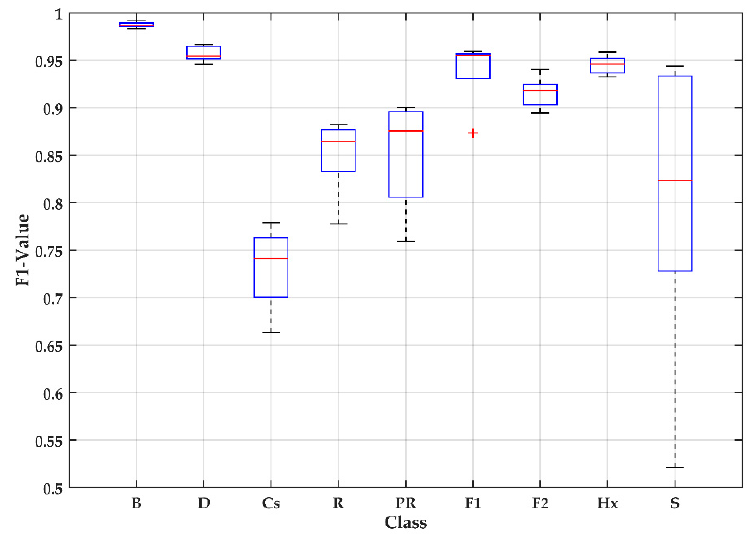
Figure 9. F1-values for each category. Figure 9. F1 ‐ values for each category.